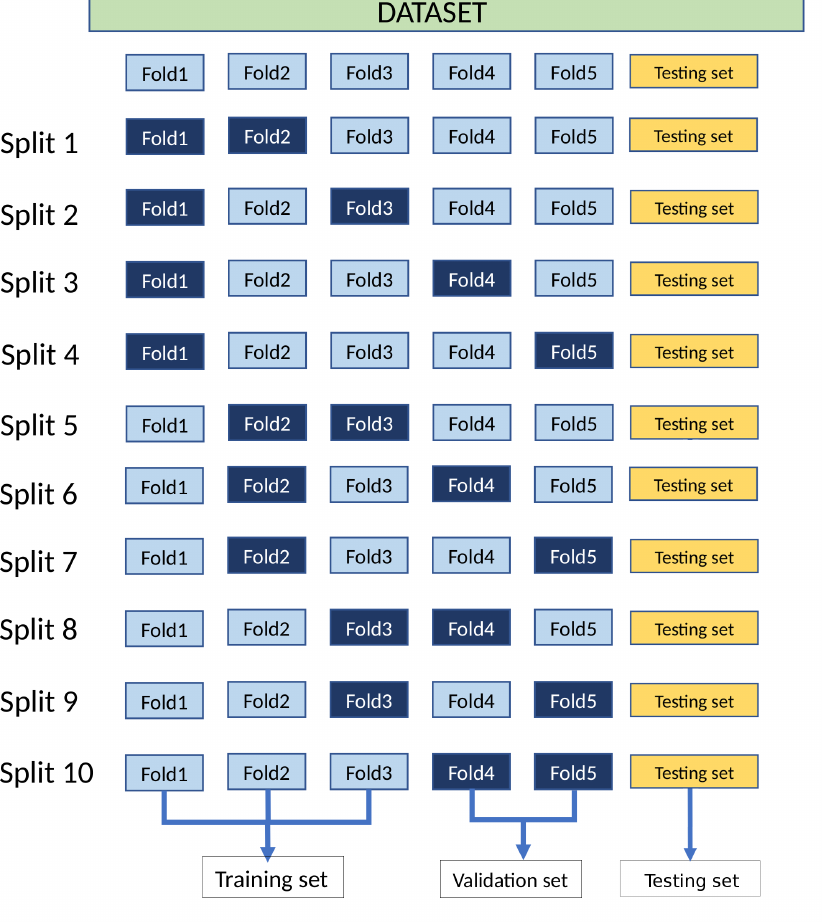
Figure 10. Stratified five-folds cross-validation and leaving two out as validation set and the rest are used for training resulting in 10 different models. Dark blue representing validation folds and light blue colour folds are used as training